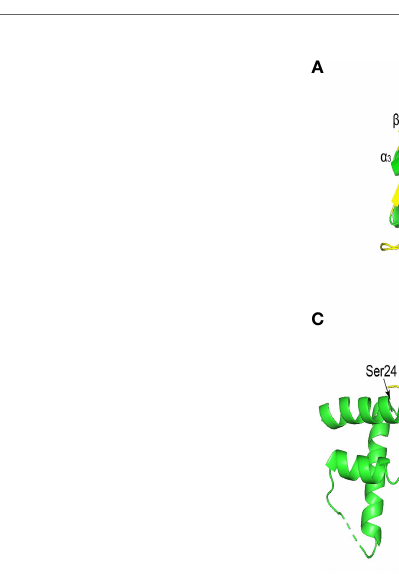
FIGURE 1 | (A) Ribbon view of ERH monomer. The a -helices and the b -strands are shown in red and in yellow, respectively. (B) View of the main-chain structures in superimposition of the three ERH monomers in the asymmetric unit. Chains (A – C) , are colored red, blue, and green, respectively. The superimposition was carried out with the program lsqkab (Kabsch 1976) in CCP4. (C) The conserved casein kinase II (CKII) phosphorylation sites (Thr18 and Ser24) are shown as a blue stick model. (D) Ribbon view of the interface of the ERH dimer. Cited Figures 1A – D (18, 19). This image was generated using PyMOL Molecular Graphics System, Version 2.0 Schrödinger,